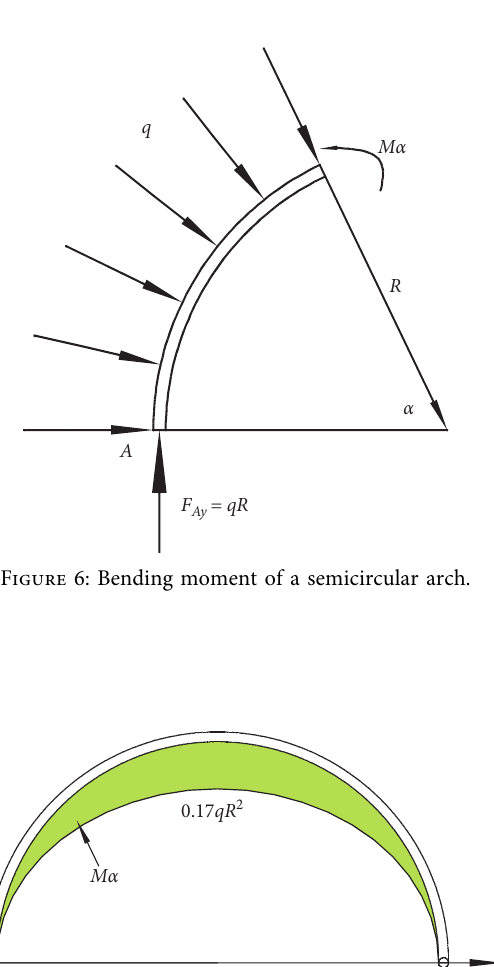
Figure 3: Experimental process of mechanical properties of RBA. (a) Uniaxial compression test. (b) Uniaxial tensile test. (c) Shear test.